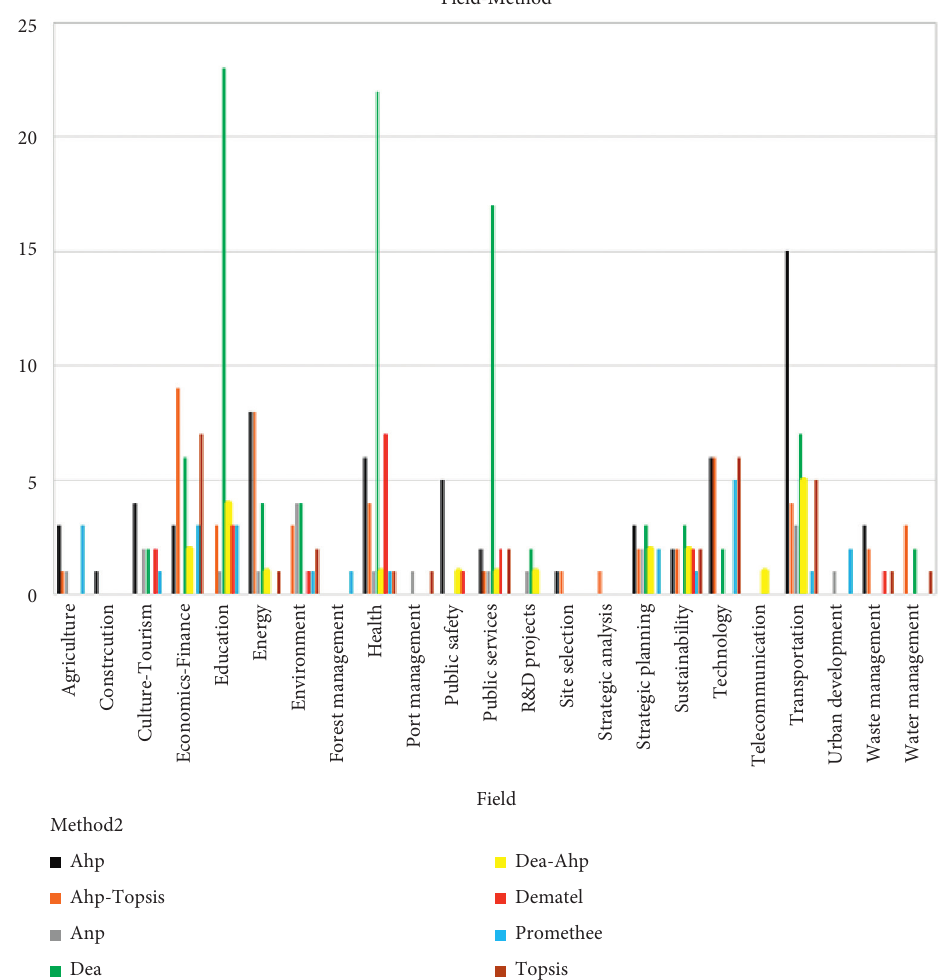
Figure 9: Crosstabulation by research field and specific